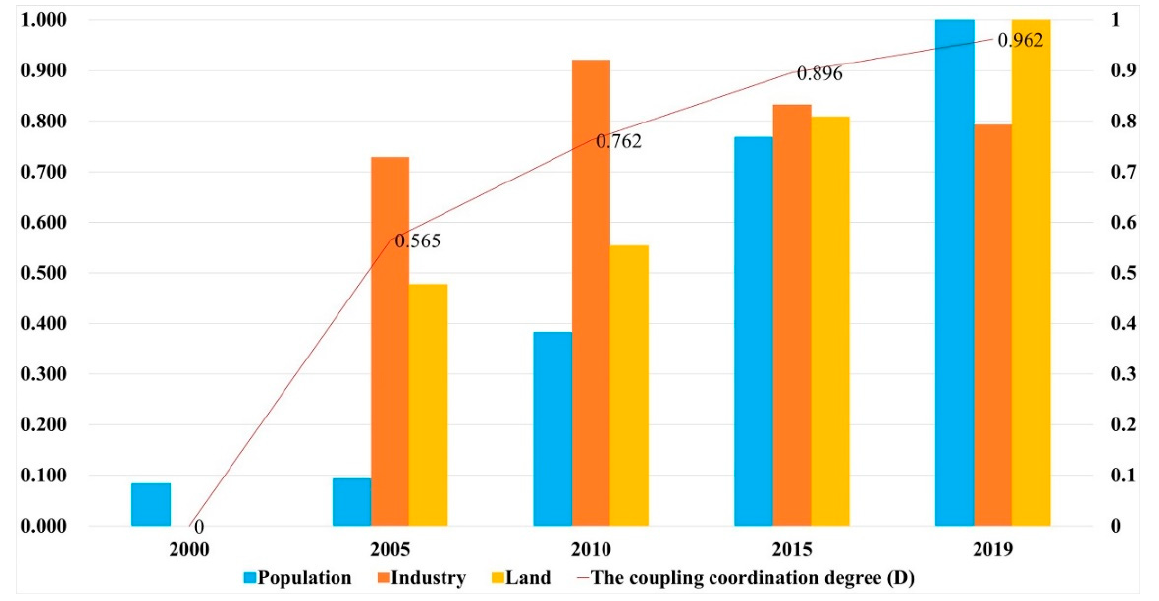
Figure 3. The city–industry integrated development in Shanghai from 2000 to 2019. The evaluation index data of the city–industry integrated development of the Kangqiao industrial park are shown in Table 9; the evaluation results are shown in Table 10 and Figure 4. Overall, the degree of city–industry integration within the park constantly improved during the study period. Table 9. Evaluation index data for the city–industry integrated development of the Kangqiao indus- trial park.